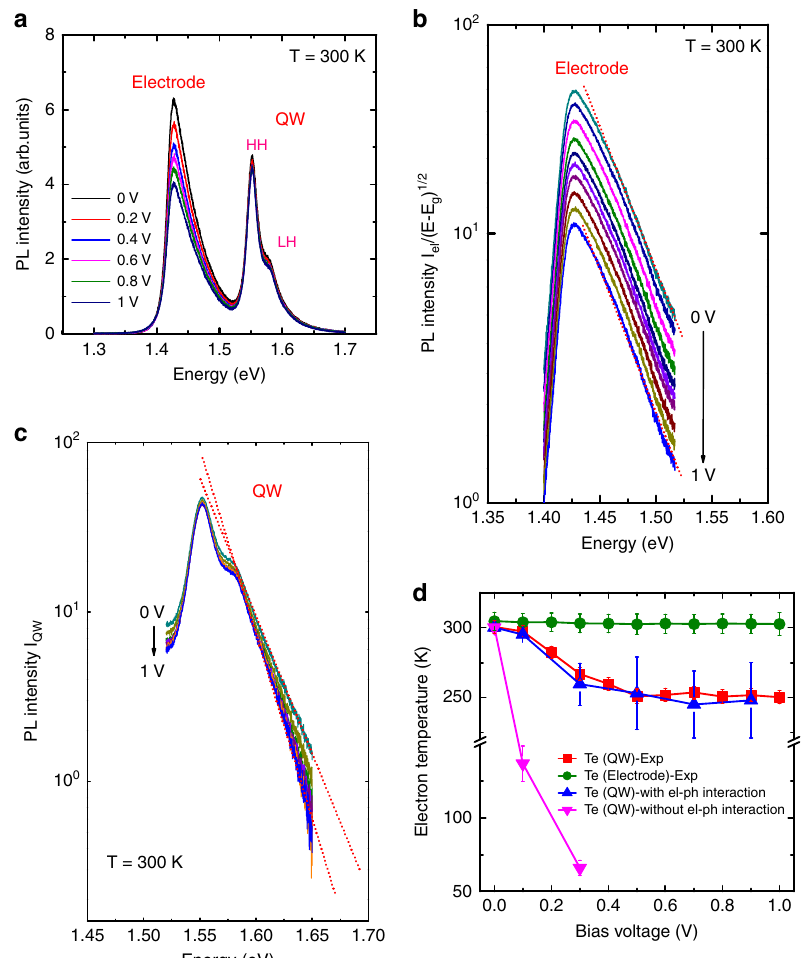
Fig. 3 Electron temperature determined from photoluminescence measurements. a Photoluminescence (PL) spectra measured at 300 K for various bias voltages. Peaks corresponding to the recombination of electrons in the quantum well (QW) with heavy holes (HH) and light holes (LH) are also highlighted. b The plot of the PL intensity of the electrode, in a logarithmic scale, as a function of the photon energy shows that the slope of the high-energy tail is bias independent. The red dotted lines are eyeguides. c The intensity of the QW PL emission as a function of the photon energy shows that the high- energy tail of the PL spectra becomes steeper as the bias voltage is increased. d The electron temperatures in the QW (red squares) and electrode (green circles) determined from PL measurements are plotted as a function of the bias voltage. The blue triangles denote the electron temperature calculated by taking into account electron-phonon interaction, showing a good agreement with the experimental data (red squares). The pink triangles are the